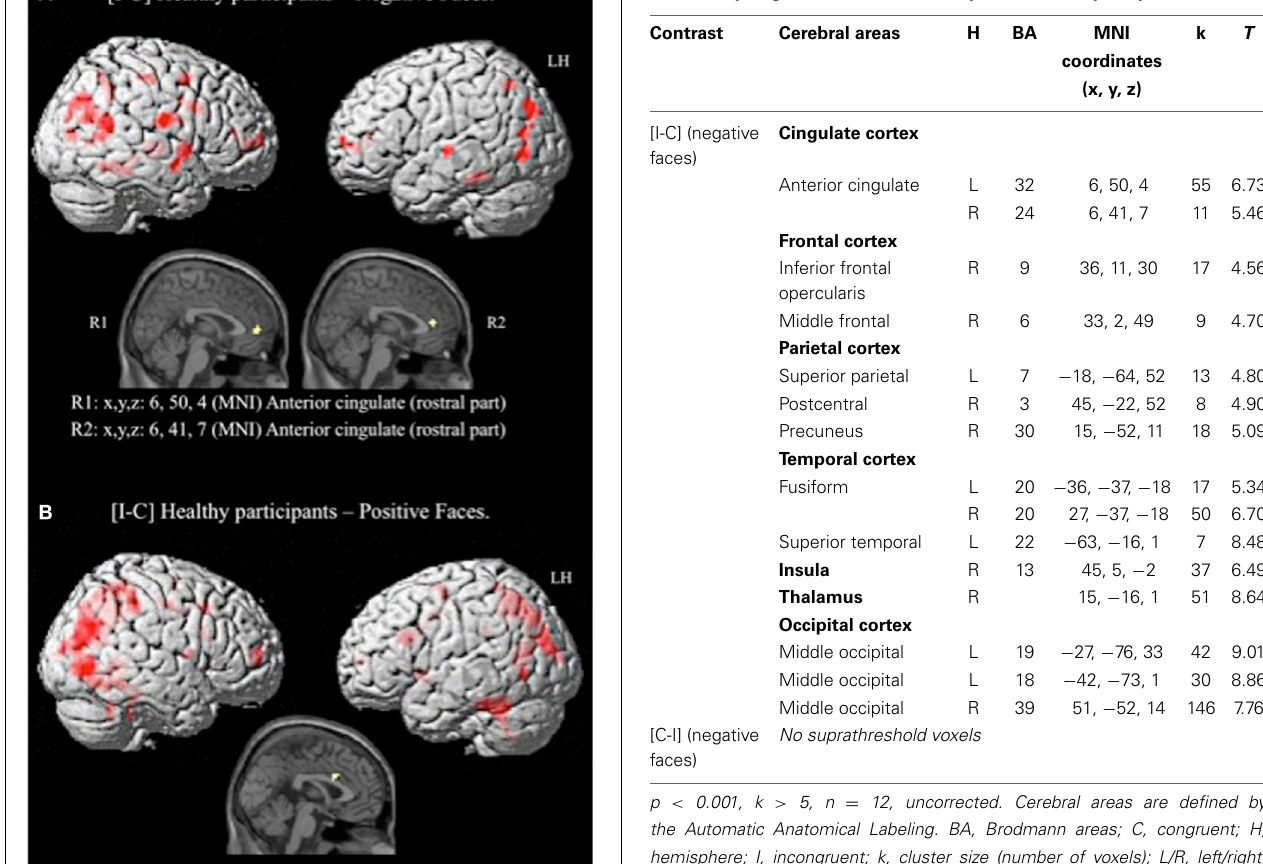
Table 4 | Brain regions activated during the emotional Stroop task when only negative faces were analyzed in healthy